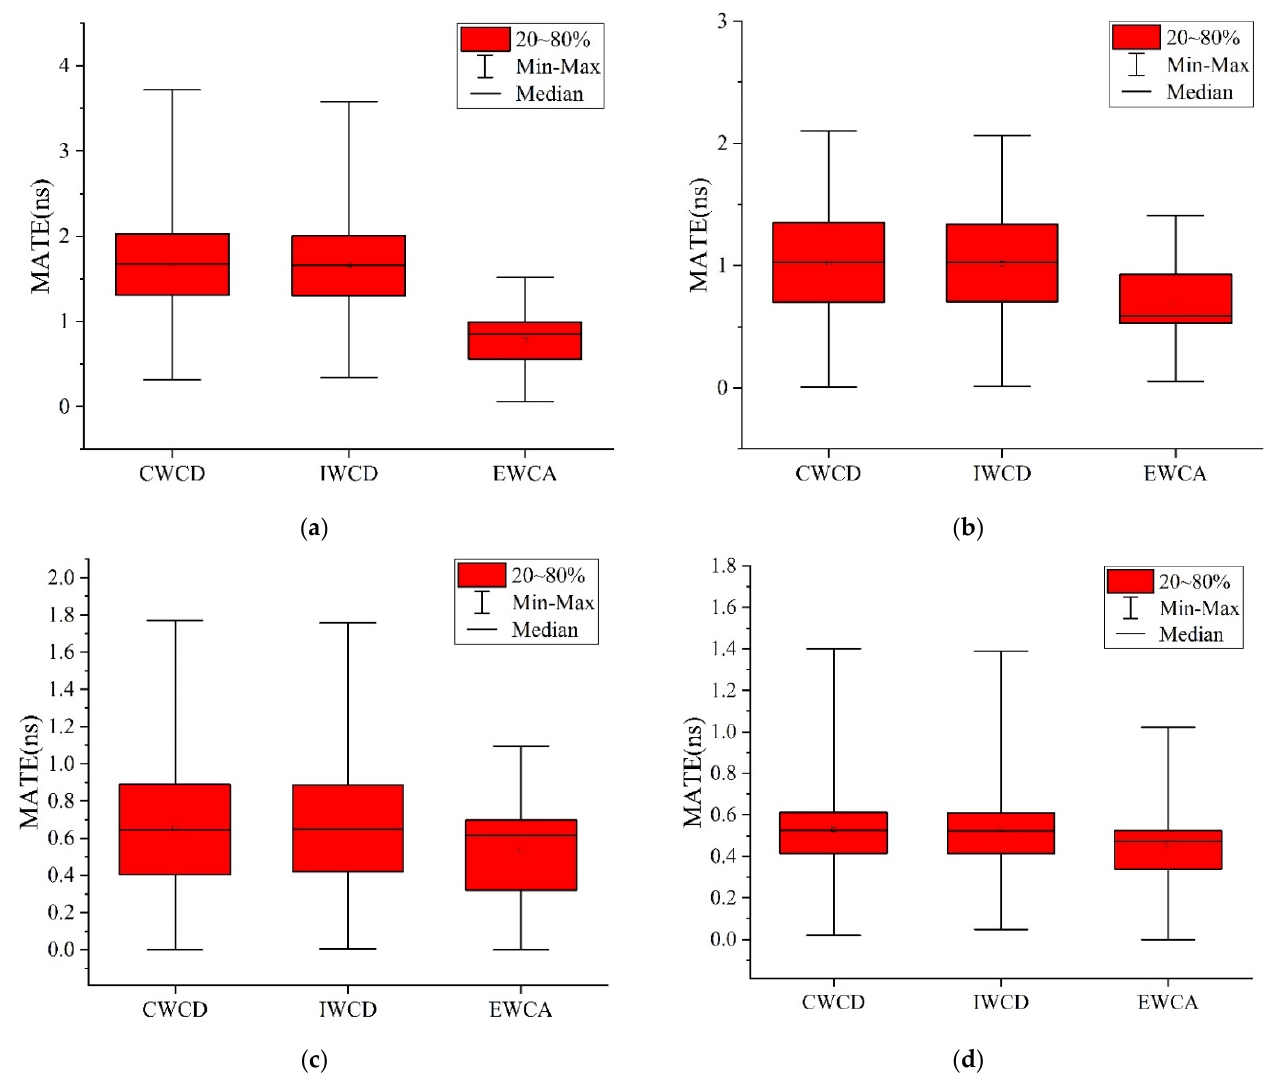
Figure 8. Mean absolute time error distribution diagram of different reflectance boards at 20 m: ( a ) the reflectance of the measurement target is 20% ( b ) the reflectance of the measurement target is 35% ( c ) the reflectance of the measurement target is 50% ( d ) the reflectance of the measurement target is 75%.